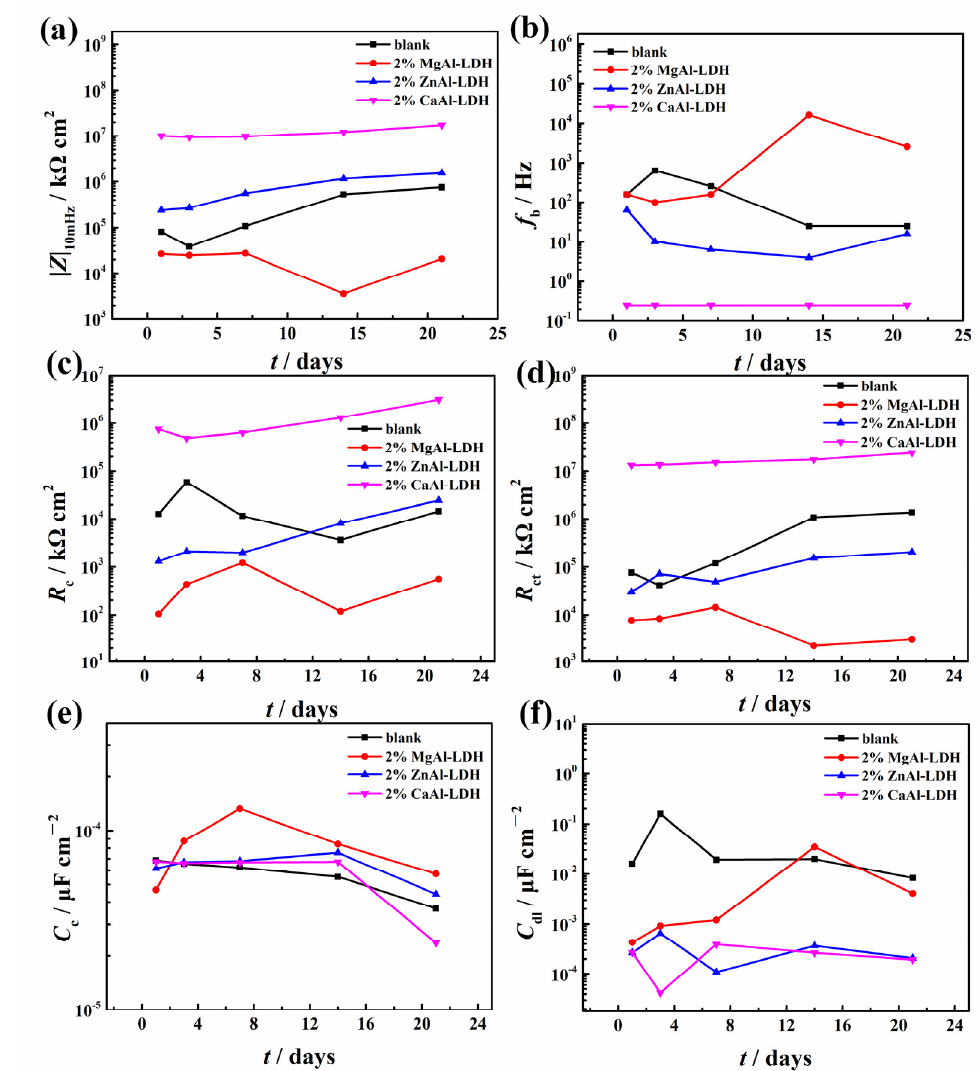
Figure 18. The variation of different EIS parameters ( a ) The impedance at 10 mHz; ( b ) breakdown frequency (frequency changes at the phase angle of − 45°( f b )); ( c ) coating resistance ( R c ); ( d ) charge transfer resistance ( R ct ); ( e ) coating capacitance ( C c ); ( f ) double layer capacitance ( C dl ) with the increase of the immersion time